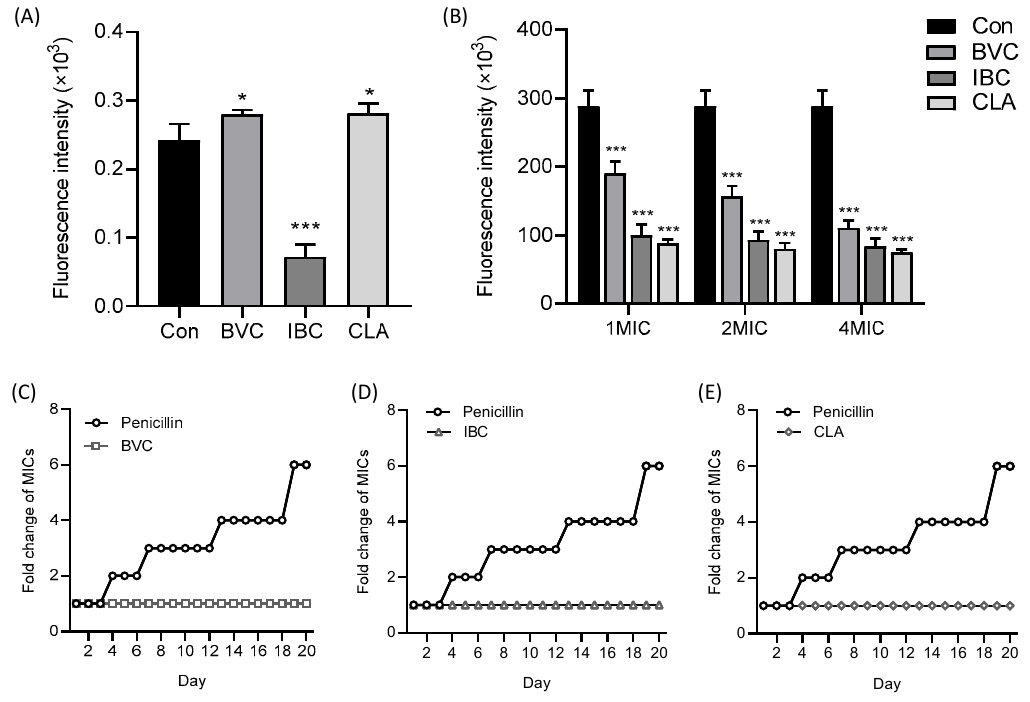
Figure 5. IPFs in PCSs exert antibacterial effects through membranes. ( A ) The fluidity of the membrane was significantly changed for MRSA after treatment with IPFs. ( B ) Membrane potential for MRSA after treatment with IPFs. No resistance to BVC ( C ), IBC ( D ), or ( E ) CLA occurred in 20-day serial passage. Values are presented as the mean ± SD. p < 0.05 was considered statistically significant, * p < 0.05, *** p < 0.01 vs. the control (Con) group.